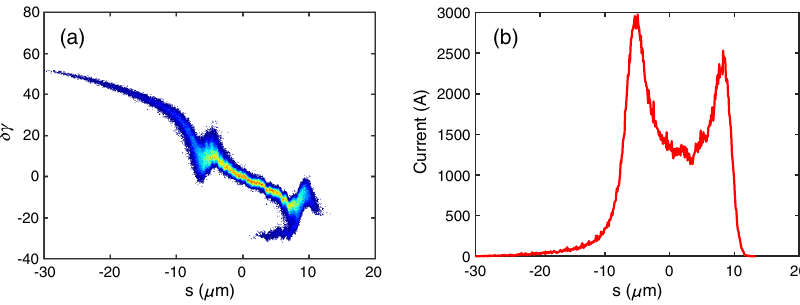
FIG. 6. The electrons distribution in phase space (a) and the corresponding current profile